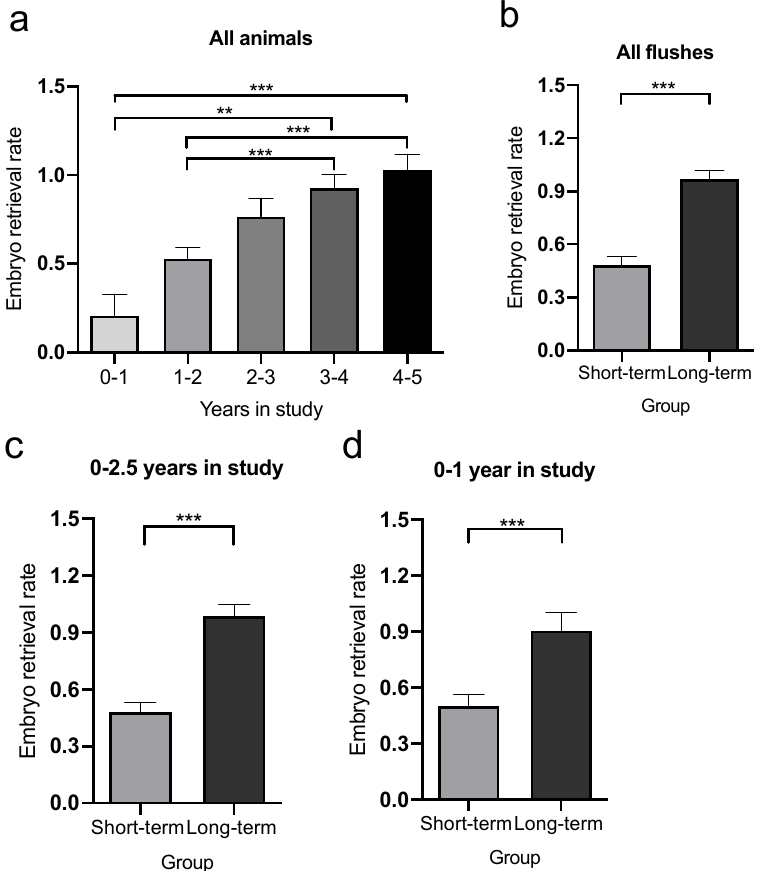
Figure 2. ERR in female marmosets ( n = 32). ( a ) Cohorts of embryo donors included for different periods of time in the study show increasing ERR with extended inclusion periods. ** p < 0.01; *** p < 0.001 ( b ) Animals were separated into LTG and STG depending on the number of anesthesias and embryo flushes (LTG: ≥ 25 flushes; STG < 25 flushes). Marmosets assigned to the LTG ( n = 12) display higher efficiency as embryo donors ( p < 0.0001) throughout the study period compared to animals in the STG ( n = 20). ( c ) High ERRs were already encountered during the first 2.5 years of experimental procedures ( p < 0.0001) and ( d ) during the first year of study ( p < 0.0001) compared to animals in the STG. Bars represent mean ± SEM. *** p < 0.001.